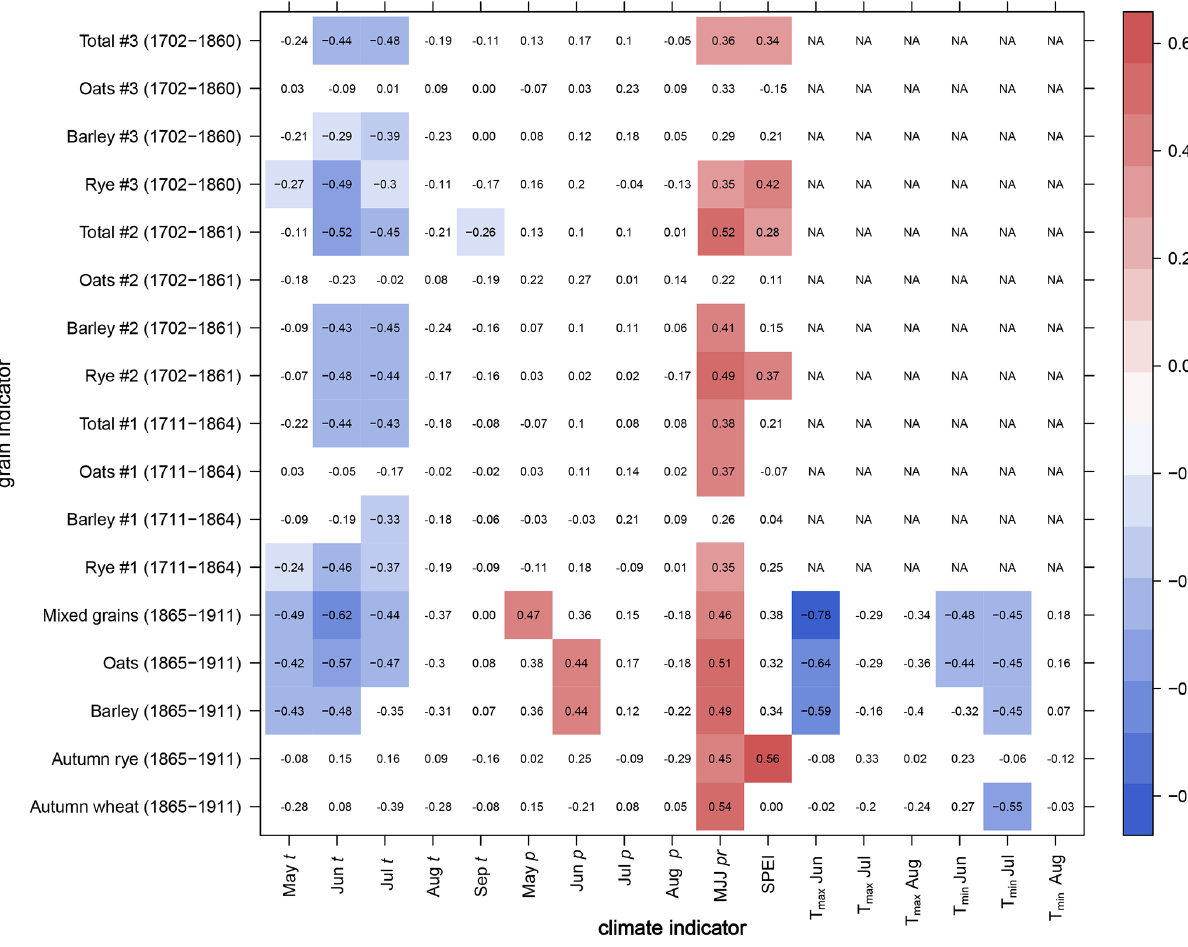
Figure 12. Correlations of grain series vs. climate indicators ca. 1702–1865 and 1865–1911 during relatively dry years. Note: only sta- tistically significant ( p ≤ 0 . 05) correlations are colored. Clusters are signified by number. Sources: HDSA, SCB (2021), Tidblom (1876), Seftigen et al. (2017, 2020), SMHI (2021), and the homogenized monthly temperature series (Appendix